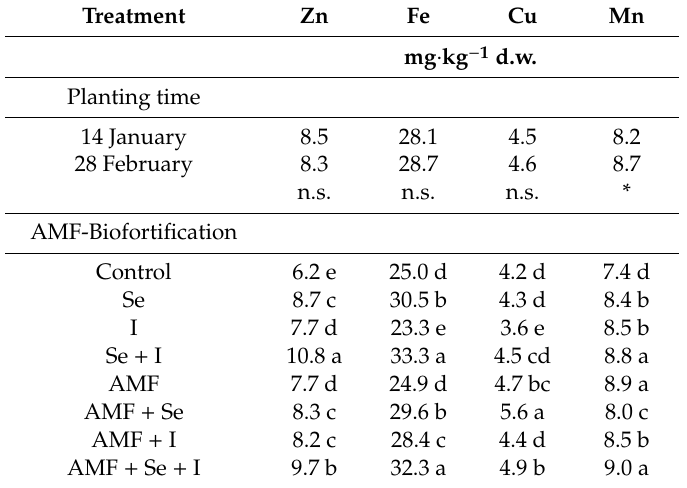
Table 6. Microelement content in chickpea seeds as a ff ected by planting time and AMF - biofortification.